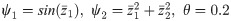
Phase portrait of the chaotic attractor for perturbed Duffing CVCSs Eq (38) when ψ1=sin(z¯1),ψ2=z¯12+z¯22,θ=0.2 and in the absence of the controller u(t).(A): On (z1r, z2r) plane. (B): On (z1i, z2i) plane.